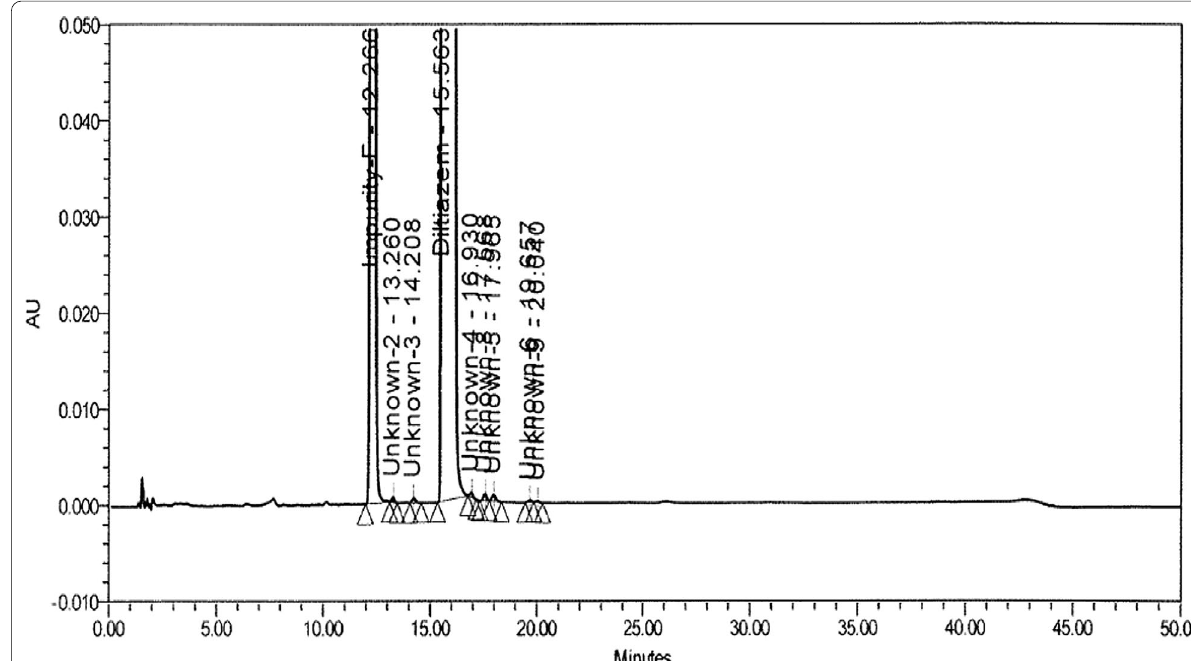
Fig. 11 Typical HPLC chromatogram of acid degradation study